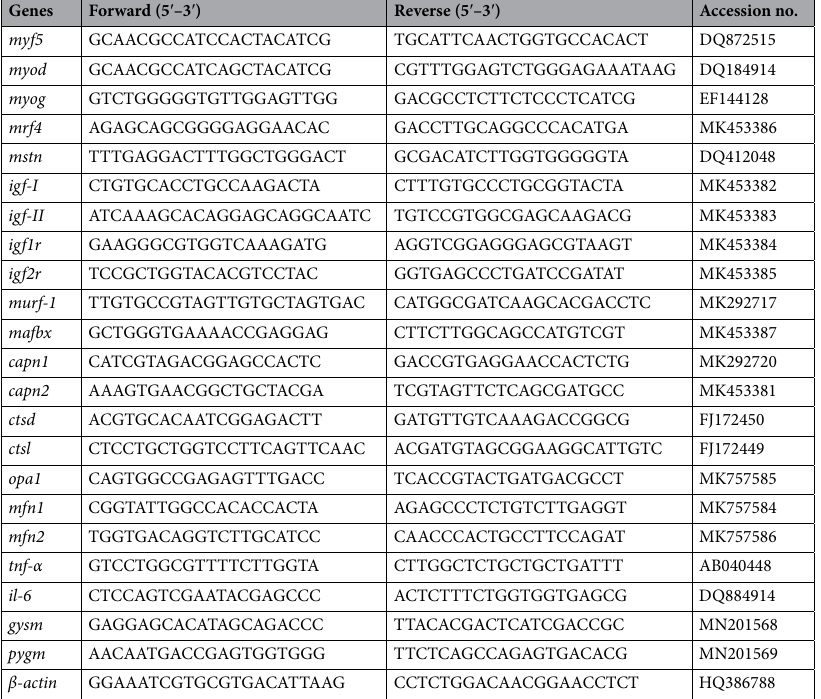
Table 5. List of PCR primer pairs used for the real-time PCR